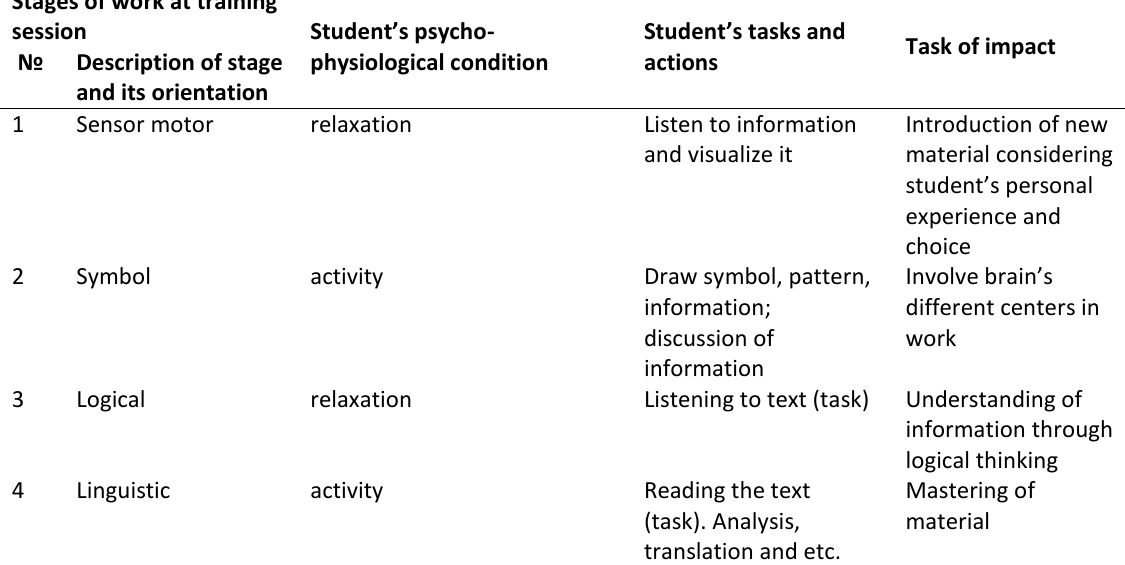
Table 1. Stages of work with information as per REAL-methodic (by N.V. Antonenko et al.)